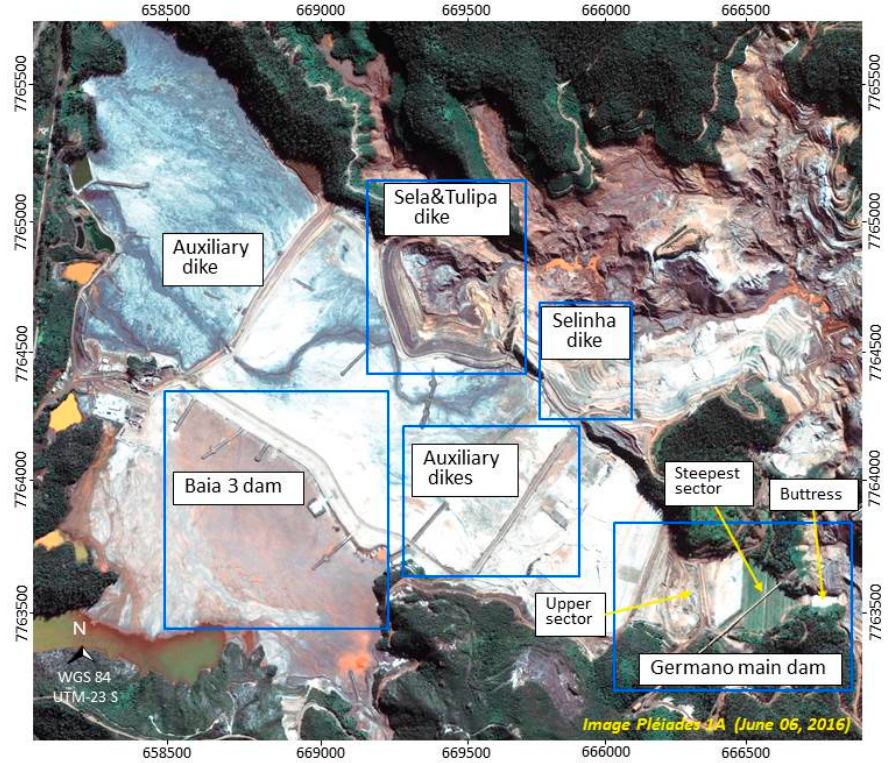
Figure 3. Study area of the main structures of the Germano dam after the Fundão collapse.